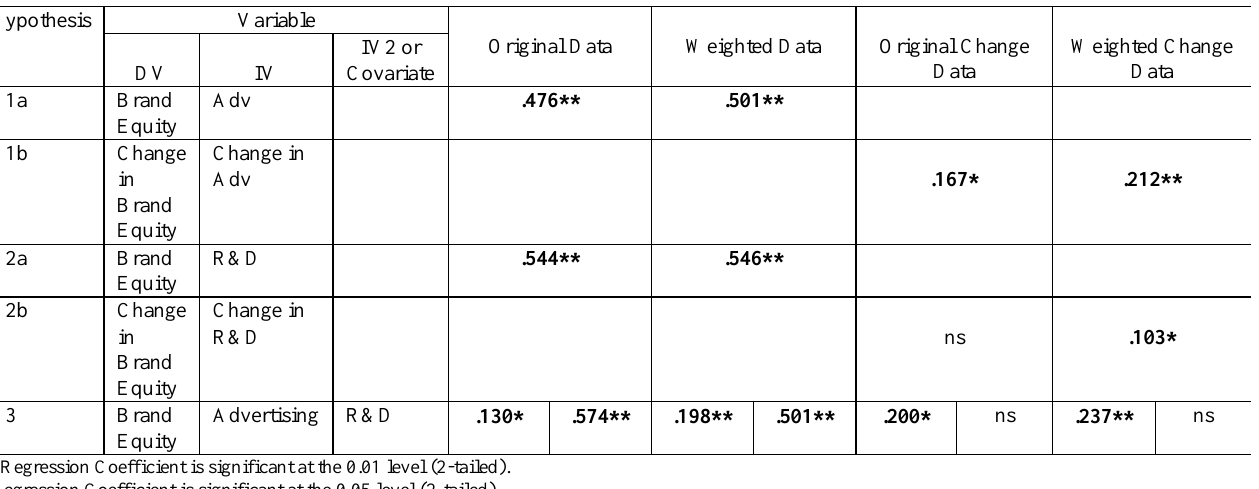
Table 1: Beta coefficients for hypotheses Hypothesis